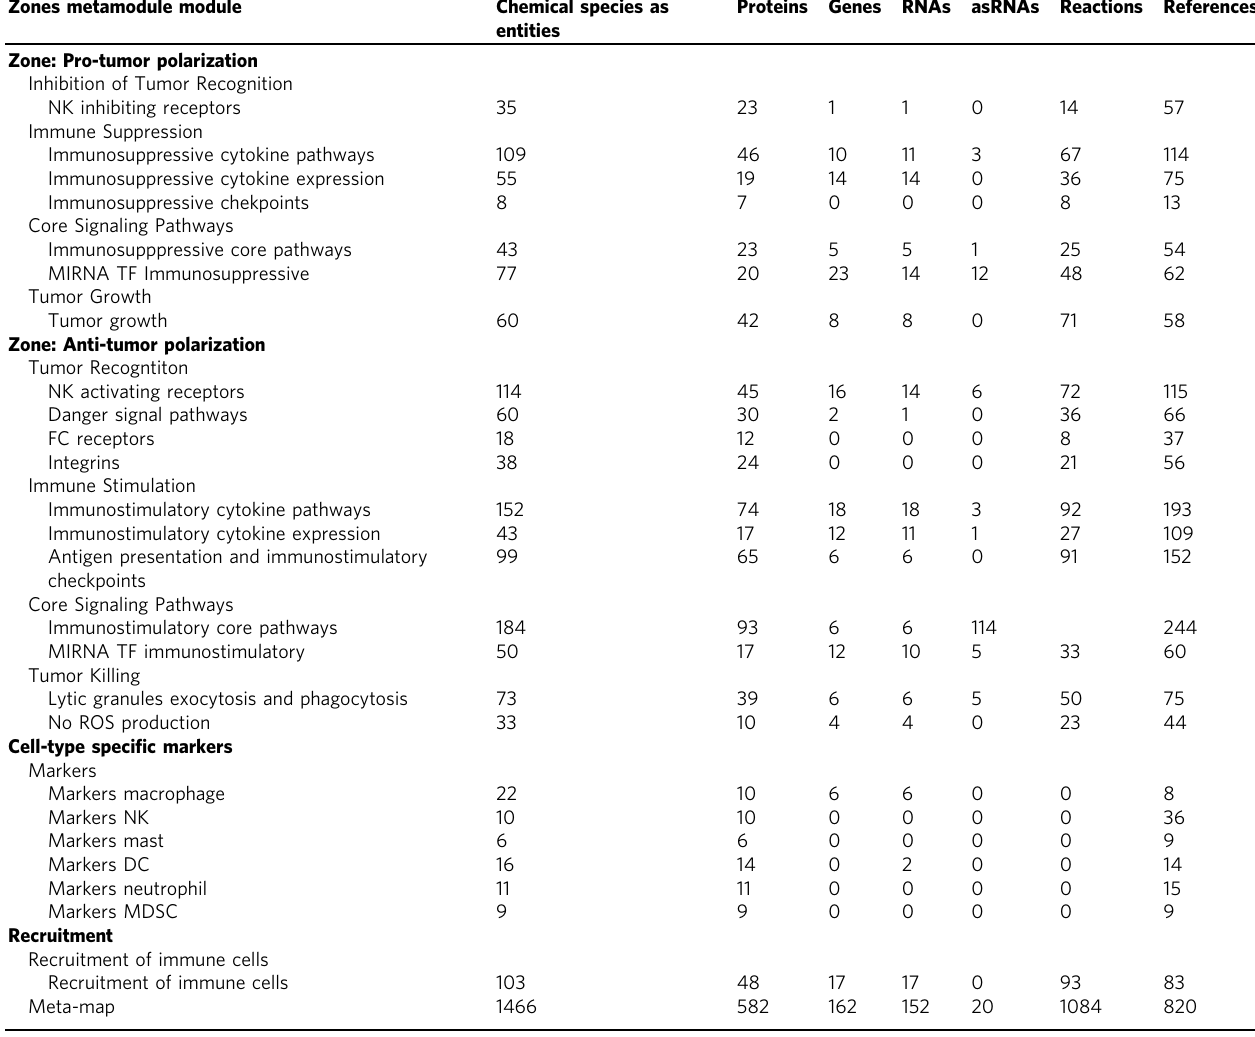
Table 1 Hierarchical modular structure of innate immune response meta-map Zones metamodule